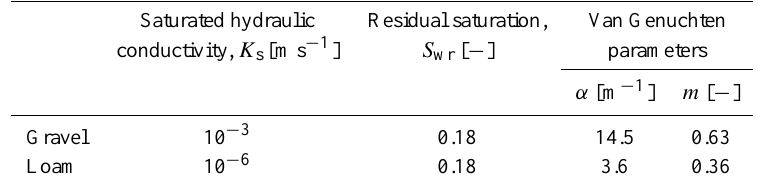
Table 1. Hydrological parameters used for the SP